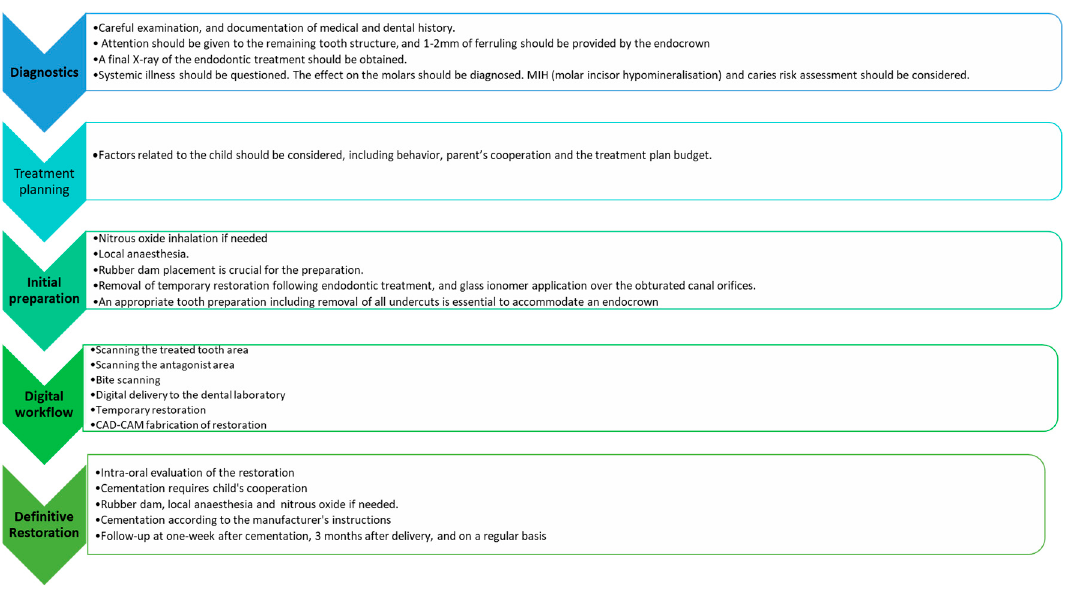
Figure 1. The suggested steps of the protocol of the endocrown treatment approach in endodontically- treated molars in